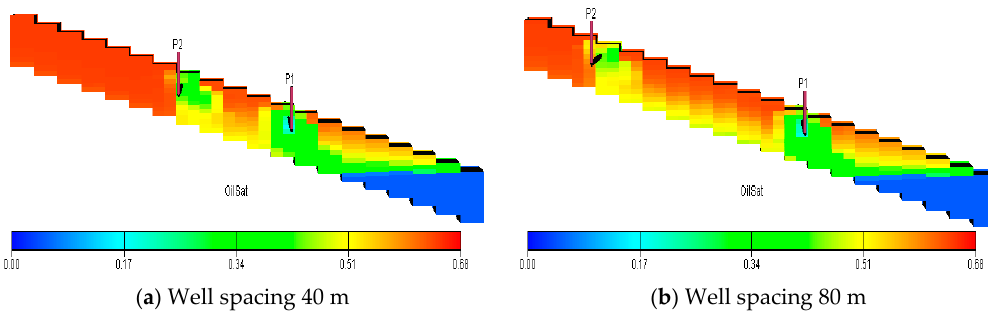
Figure 21. Oil saturation distribution after validity period.